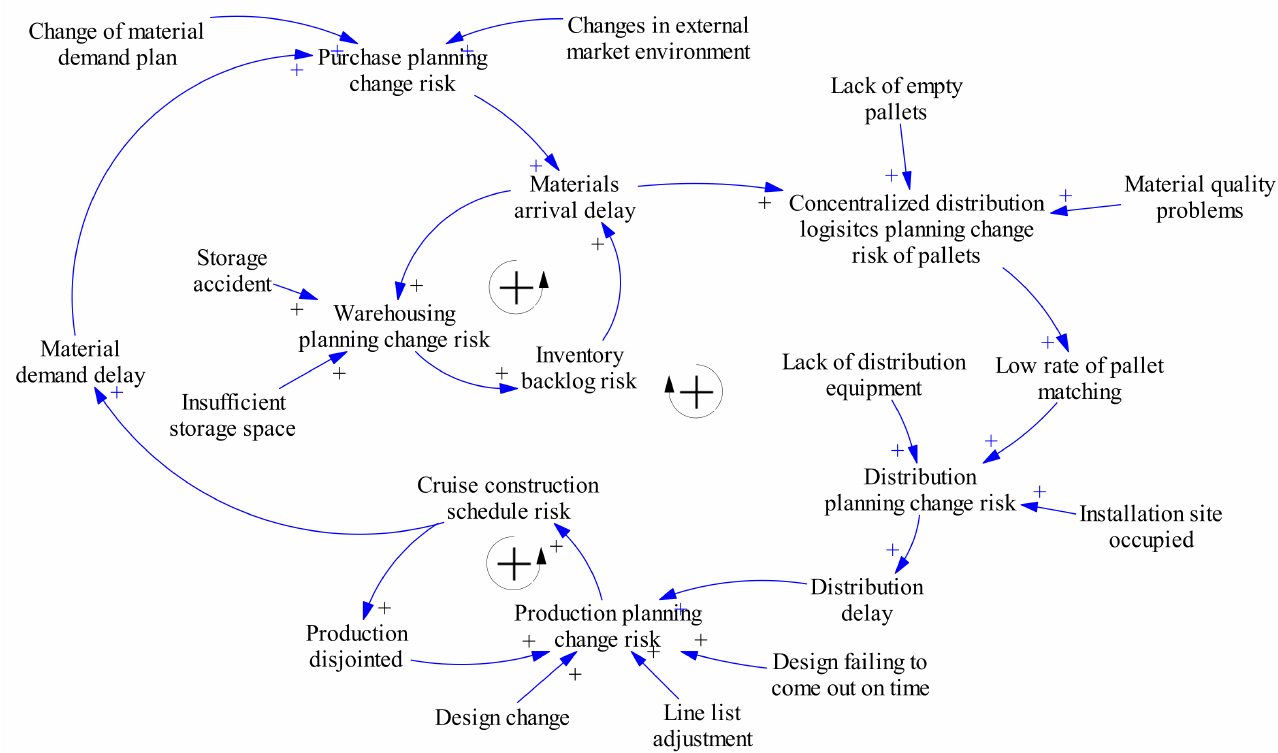
Figure 3. Causal loop